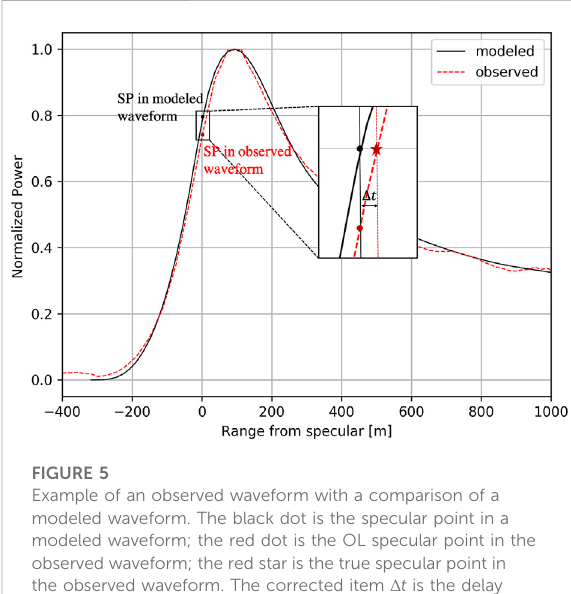
FIGURE 5 Example of an observed waveform with a comparison of a modeled waveform. The black dot is the specular point in a modeled waveform; the red dot is the OL specular point in the observed waveform; the red star is the true specular point in the observed waveform. The corrected item Δ t is the delay difference between the OL specular point and the true specular point in the observed